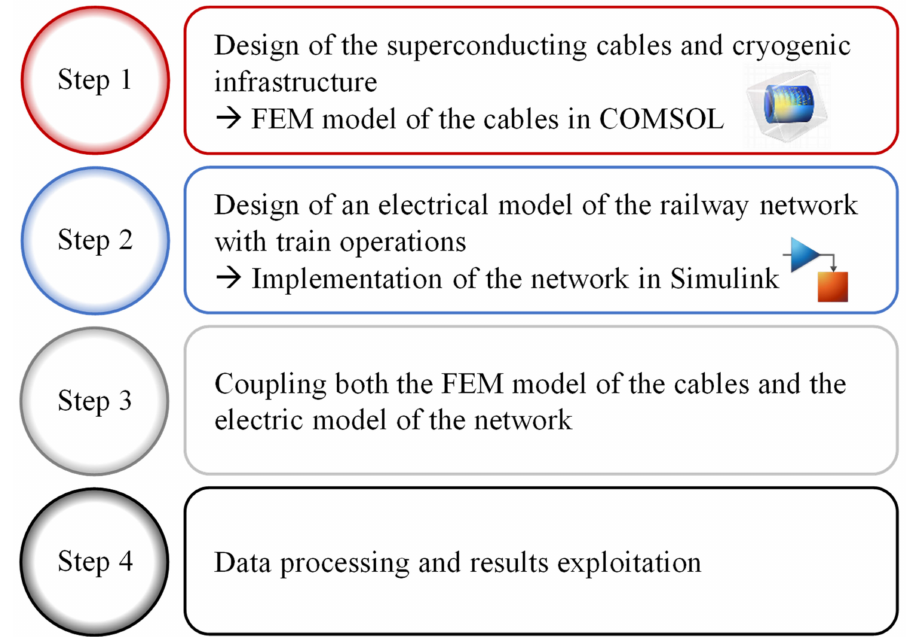
Figure 2. Procedure followed to establish the transient simulation of a superconducting cable on a railway network, from the initial data collection to the data processing and